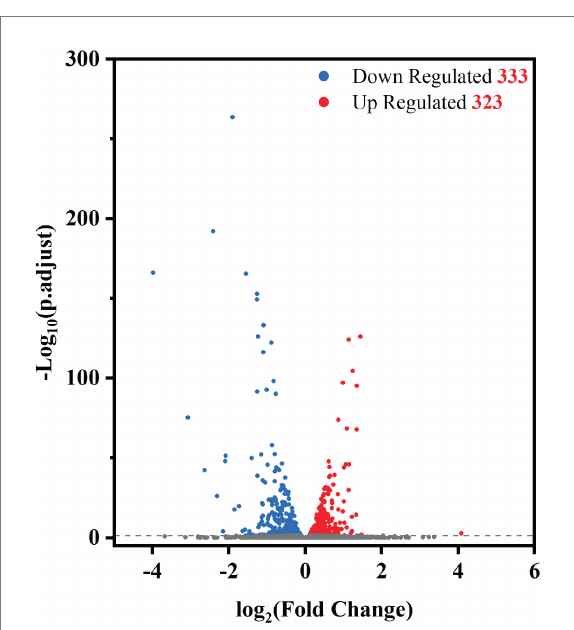
FIGURE 4 Volcano plot of differentially expressed genes between PD-pdeR and PD-pBBR (red, up-regulated genes; blue, downregulated genes; gray, non-differentially expressed genes).